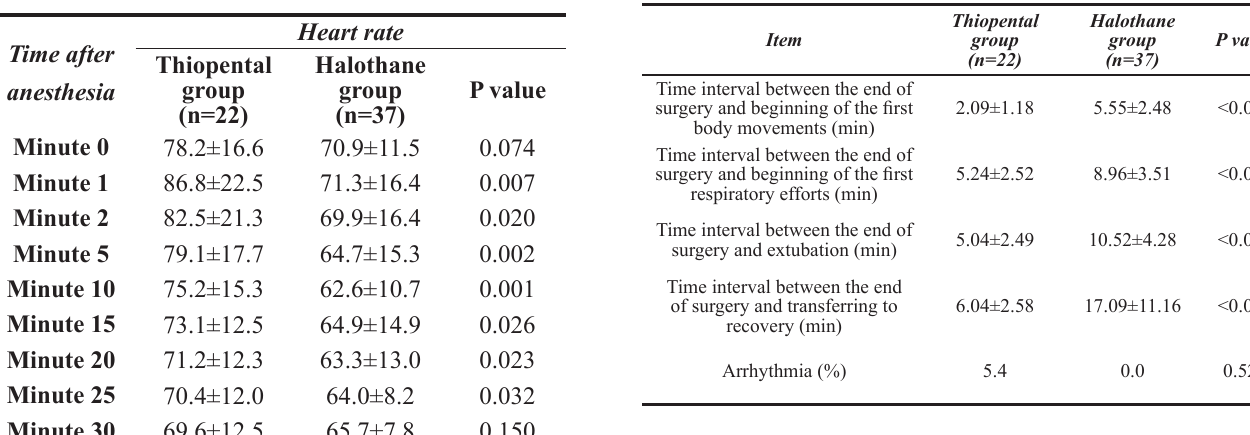
TABLE 5 - Postoperative outcome of the patients received thiopental and halothane.